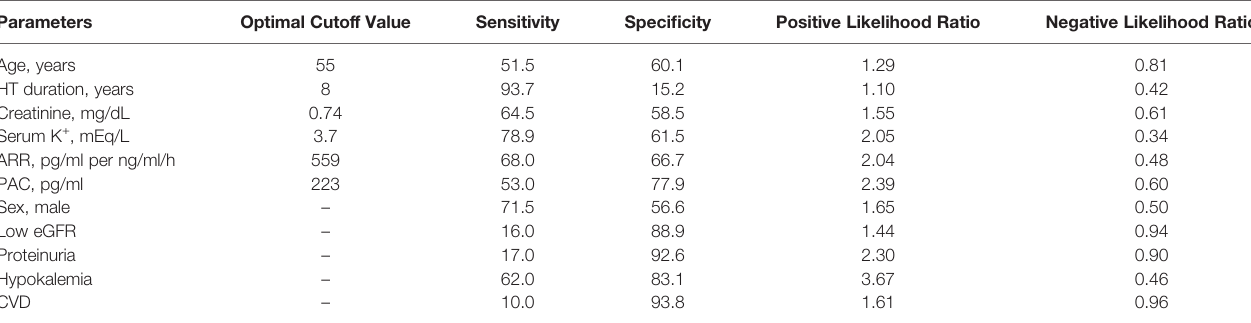
TABLE 3 | Optimal cutoff values for each parameter and its sensitivity, speci fi city and likelihood ratio distinguishing unilateral PA patients without apparent adrenal tumors from bilateral PA patients. Parameters